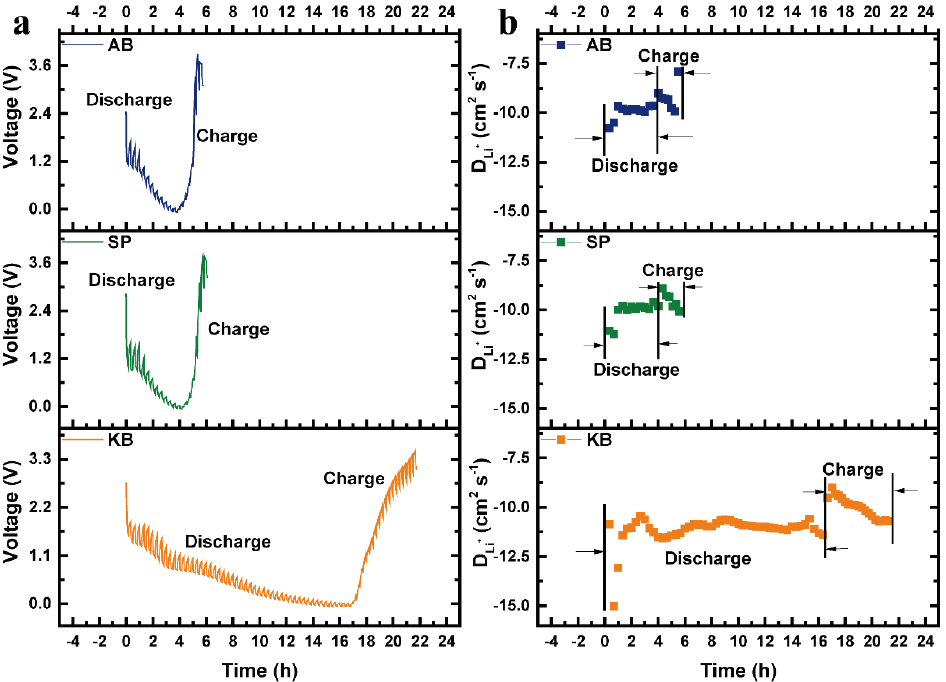
Figure 8. The voltage change curve of the first charge/discharge under pulse current ( a ) and Li-ion diffusion coefficient calculated from the pulse charge/discharge curve ( b ) with different carbon conductive agents.